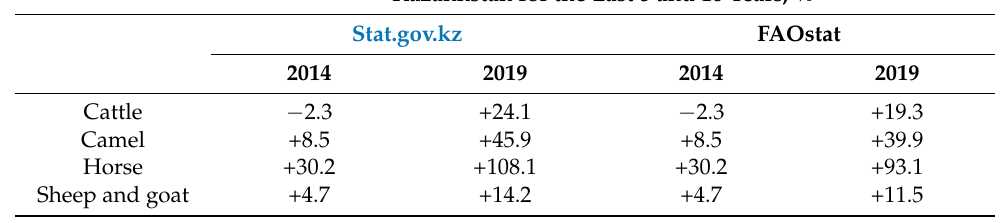
Table 6. Livestock population growth in the Republic of Kazakhstan between 2009 and 2019 (index 100 in 2009) (source: Stat.gov.kz, 2021 and FAOstat. Available online: https://stat.gov.kz/ (accessed on 26 May 2021) and www.fao.org (accessed on 26 May 2021). Dynamics of Changes in the Number of Livestock in the Republic of Kazakhstan for the Last 5 and 10 Years, % Stat.gov.kz